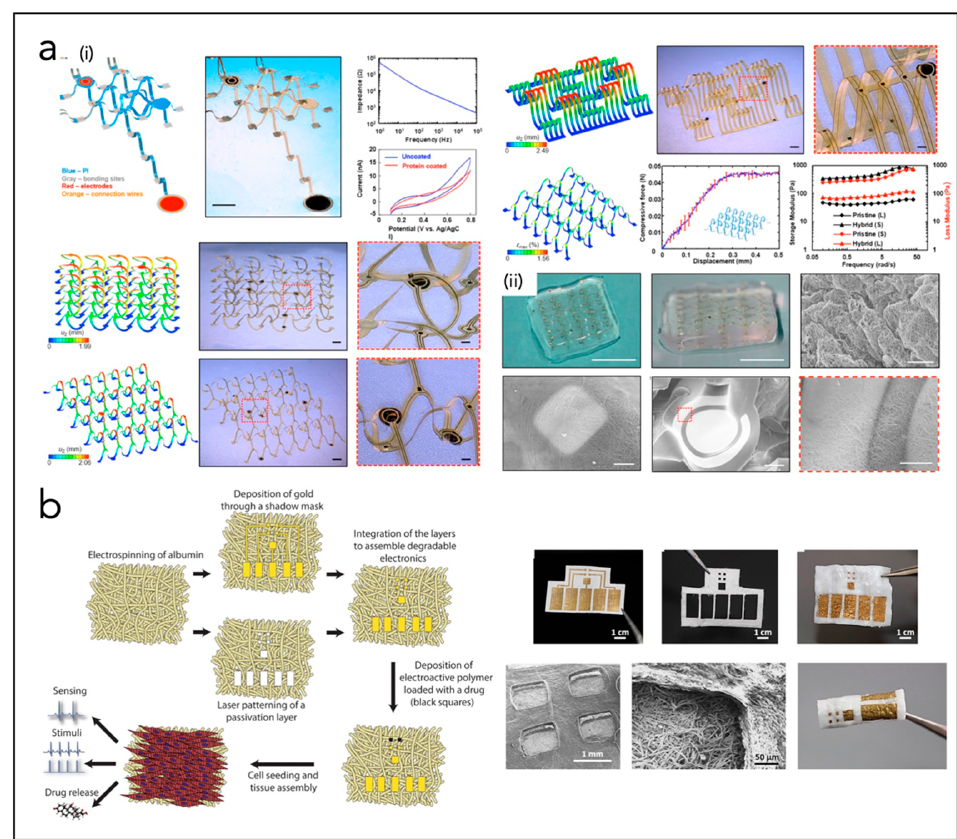
Figure 9. Bioelectronics integrated with cardiac patches as in vitro cardiac models. ( a ) 3D electronic scaffolds formed by mechanically-guided assembly (i) and integrated into an extracellular matrix hydrogel (ii) for monitoring and regulation of multifunctional hybrid tissues. Adapted with per- mission from reference [227], 2020 Copyright Elsevier. ( b ) Degradable electronic scaffolds based on electrospun albumin for cardiac tissue engineering. Adapted with permission from reference [229], 2018 Copyright